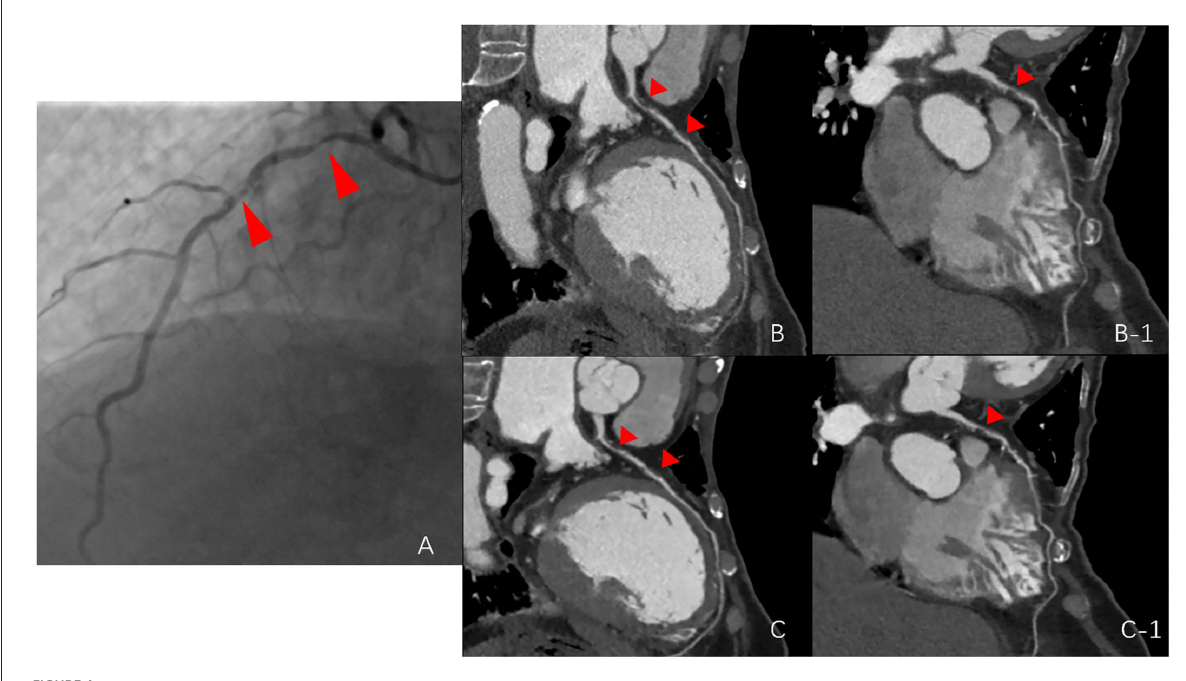
FIGURE4 Comparison among the routine group, SE group, and digital subtraction angiography (DSA) group. (A) stenosis of the DSA group (red arrows point to the left anterior descending artery); (B,B-1) , stenosis of the routine group; and (C,C-1) , stenosis of the SE group.